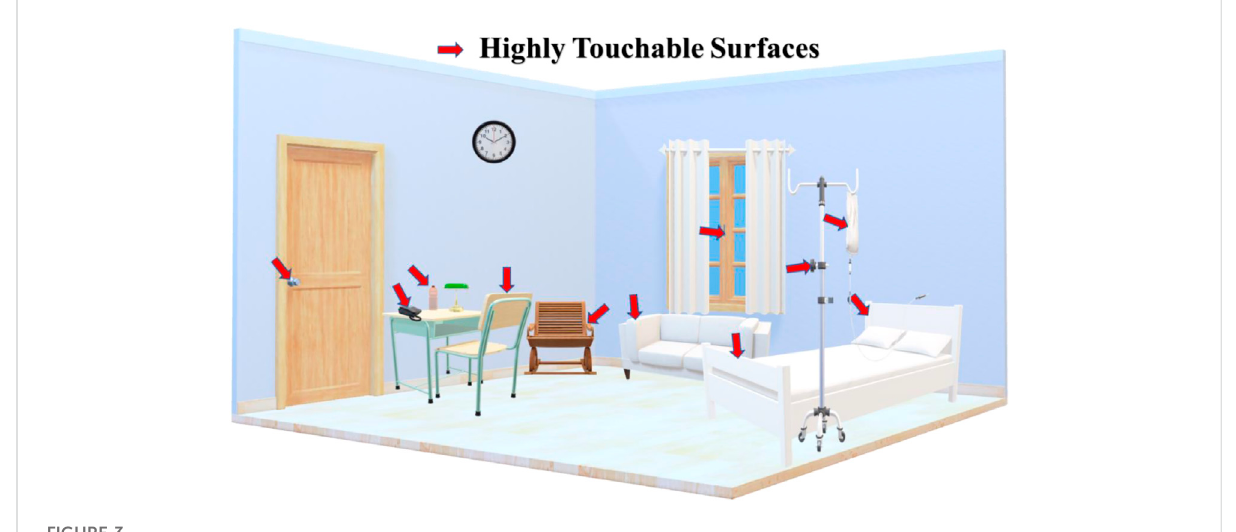
FIGURE 3 High touch surfaces in hospital